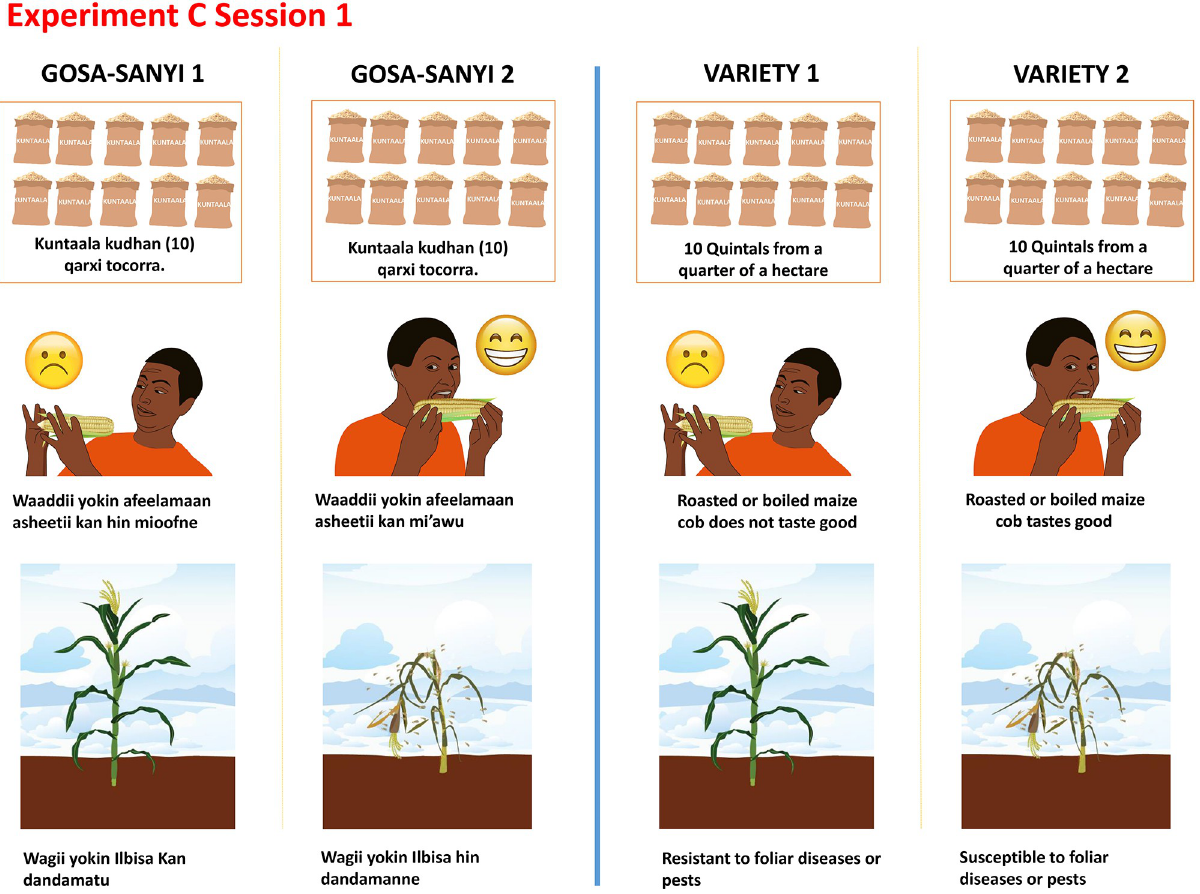
Fig 1. Comparing willingness to pay estimates for maize traits from BDM and choice